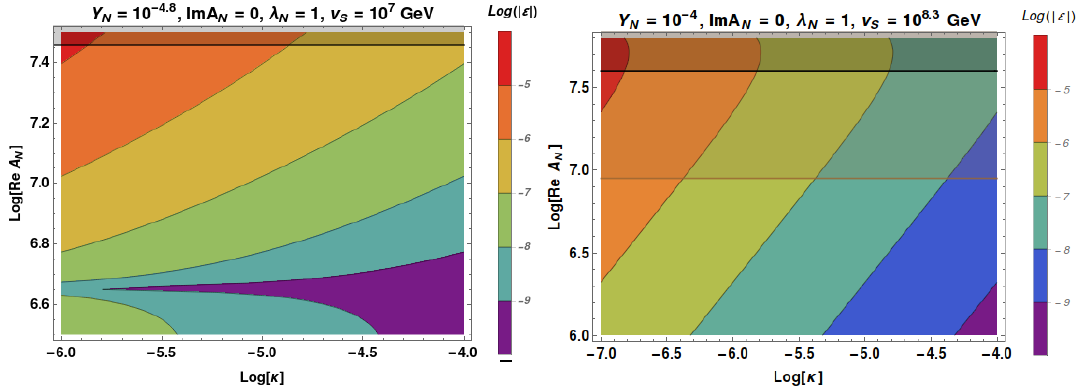
Figure 6 . The contour plots of " in Re A N (cid:0) (cid:20) plane considering a real A N . The left panel shows only the out-of-equilibrium bound ((cid:0) H ( z = 1), in horizontal black solid line) with a generic ’ A N . In the right panel the horizontal brown solid line marks the leading order approximation in the soft-term A N ( A 2 =M 2 10 (cid:0) 3 ), while the black line is the out-of-equilibrium bound. All 1 ’ N logarithms are to the base